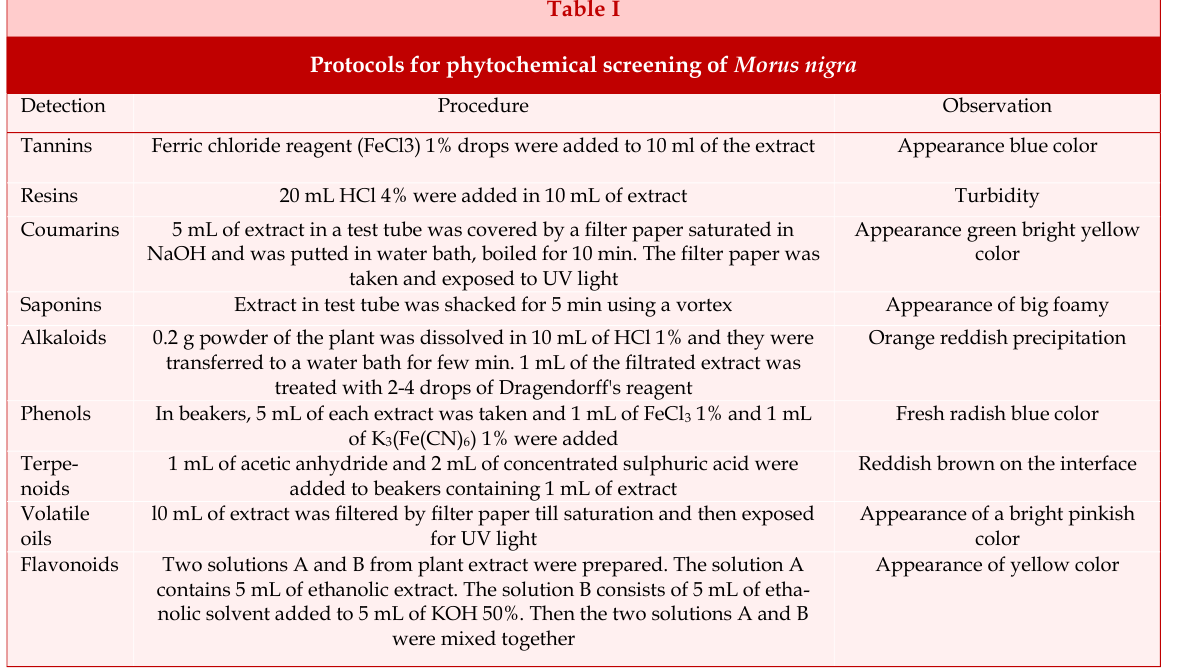
Figure 1: Summary of study methodology